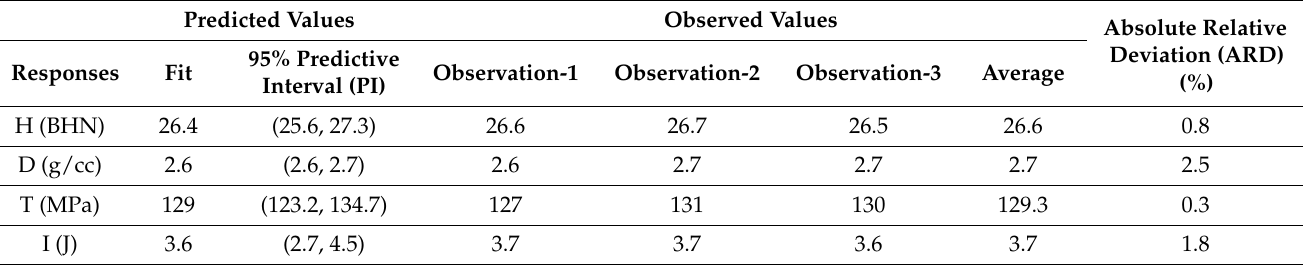
Table 6. Predicted and observed response of the optimal mixture